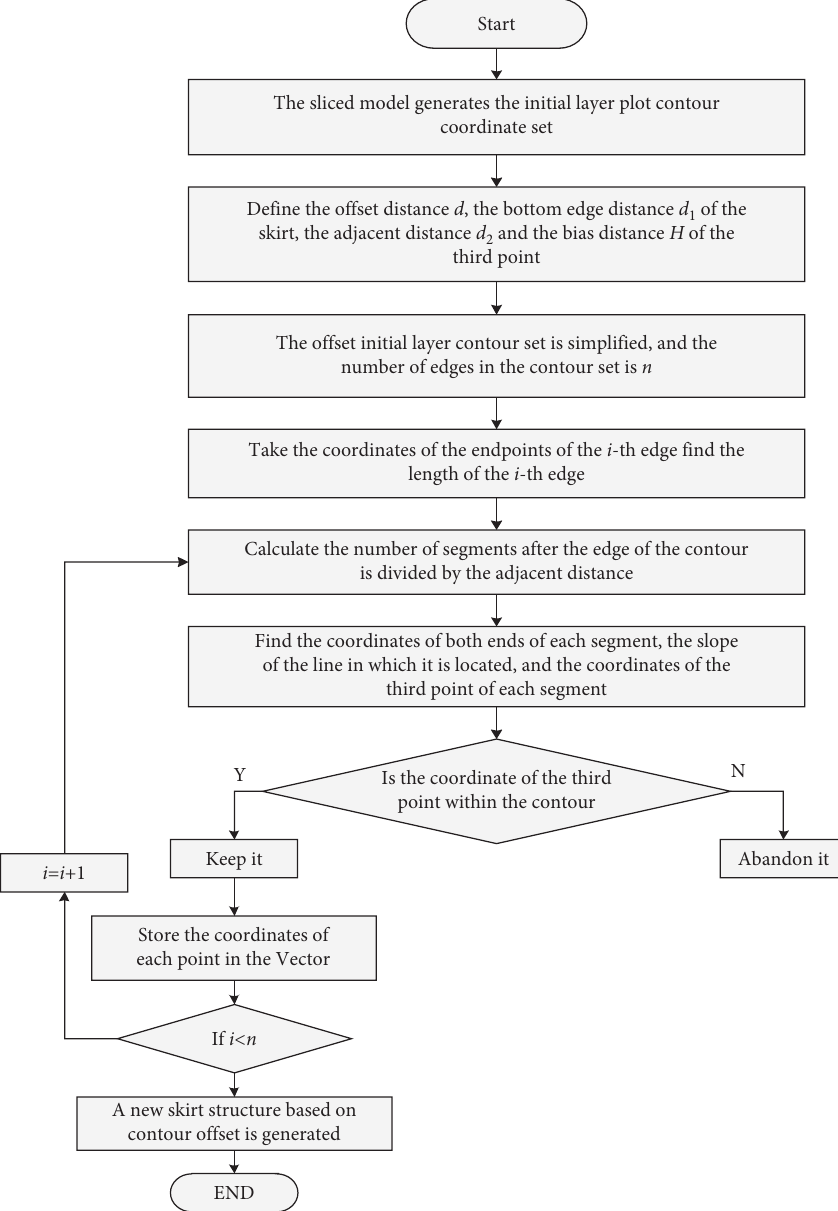
Figure 7: Calculation process of generating a new platform attached support